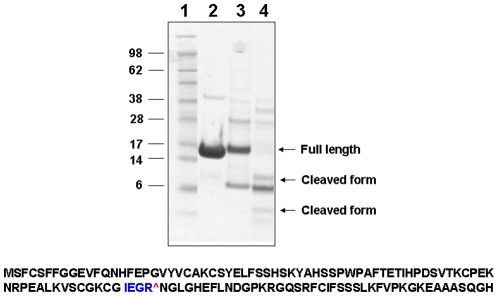
Analysis of recombinant MsrB1.Top panel: Cys mutant of MsrB1 (MsrB1-Cys) (lane 2) and its form with the engineered factor Xa protease cleavage site (MsrB1-Cys-Xa) (lane 3) were analyzed by SDS-PAGE followed by Coomassie Blue staining. MsrB1-Cys-Xa protein was digested with factor Xa and the digestion products (lane 4) were subjected to SDS-PAGE analysis. Molecular weight markers are shown in lane 1. Arrows indicate migration of the uncleaved (full length) protein and cleaved protein fragments (cleaved form). Bottom panel: Sequence of MsrB1-Cys-Xa. The engineered factor Xa site is shown in blue, U95C in orange, and the factor Xa cleavage site is shown by “∧”.